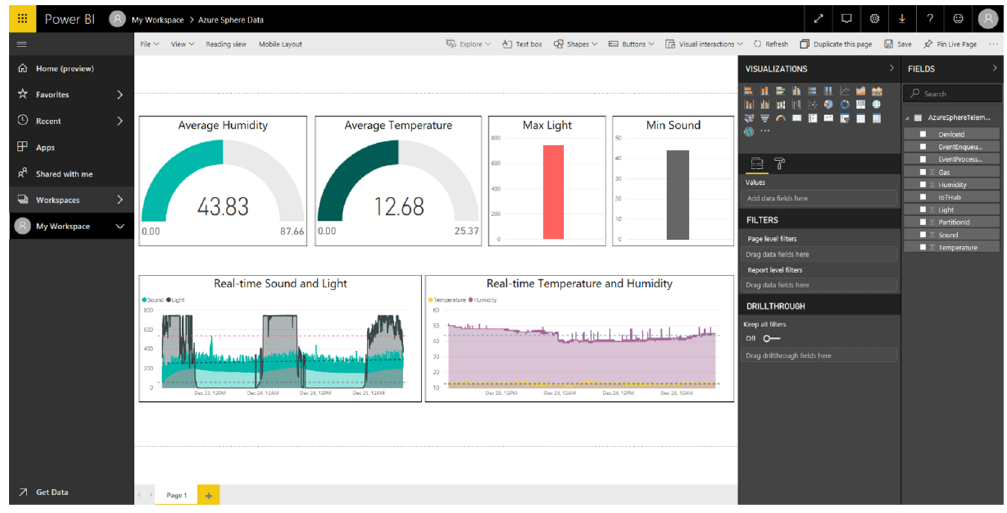
Figure 8. Editor view for Power BI reports.